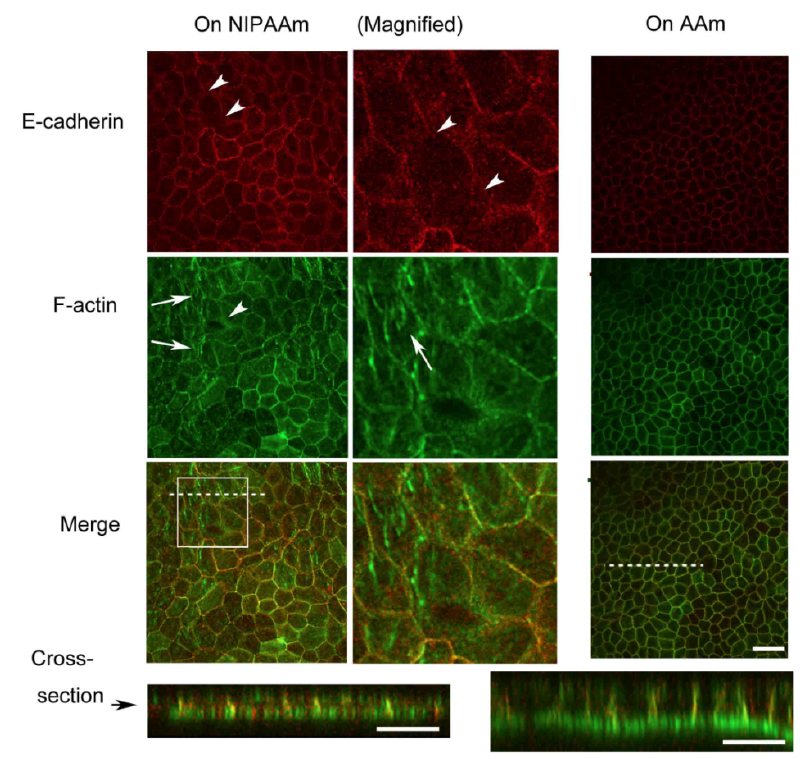
Figure 5. Representative picture of immunostained cells on each gel section. The center column shows magnified images of insert areas outlined in the merged image of PNIPAAm. Images were obtained by confocal microscopy. Location of cross-section is indicated by a white dashed line in the merged picture. Cells on the collagen-immobilized PNIPAAm gel side were clearly larger in cellular area and flattened. In some domains, obvious F-actin (arrow) and/or vanished E-cadherin (arrow head) were observed. Note that all F-actin or E-cadherin images were observed in the same condition, e.g., pinhole size, scanning rate and gain of photon counter. E-cadherin in the cells on the collangen- immobilized PNIPAAm was more brightly stained compared with that in cells on the collagen-immobilized PAAm side. Scale bar: 50 μ